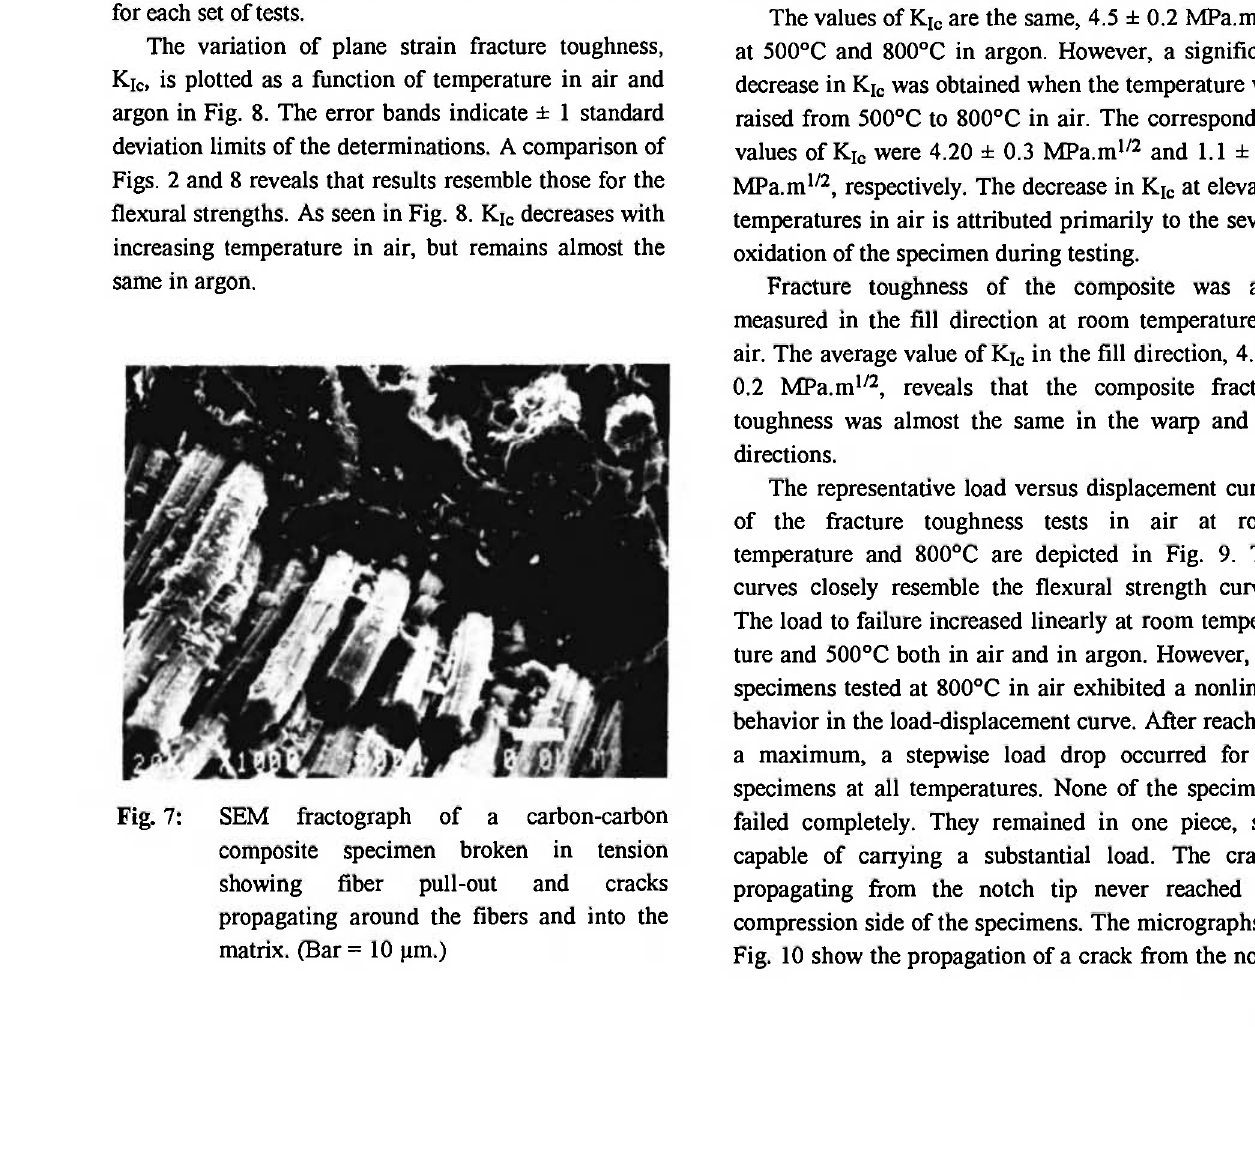
Fig. 7: SEM fractograph of a carbon-carbon composite specimen broken in tension showing fiber pull-out and cracks propagating around the fibers and into the matrix. (Bar = 10